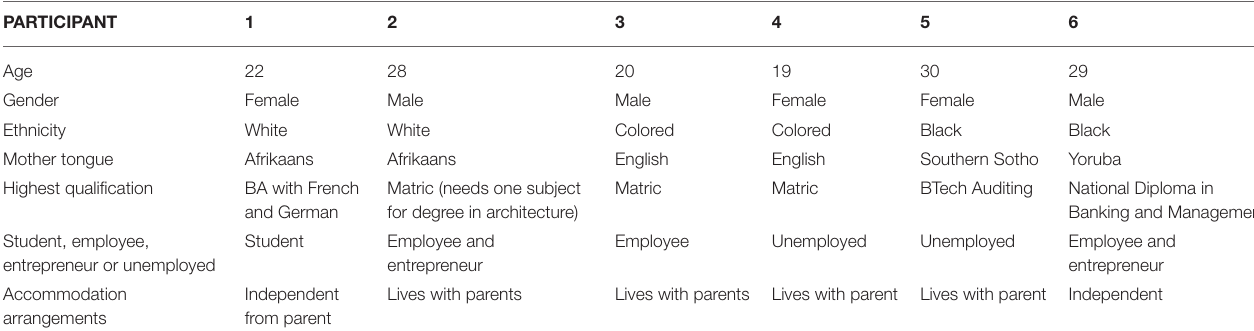
TABLE 1 | A summative overview of the background information regarding the participants.